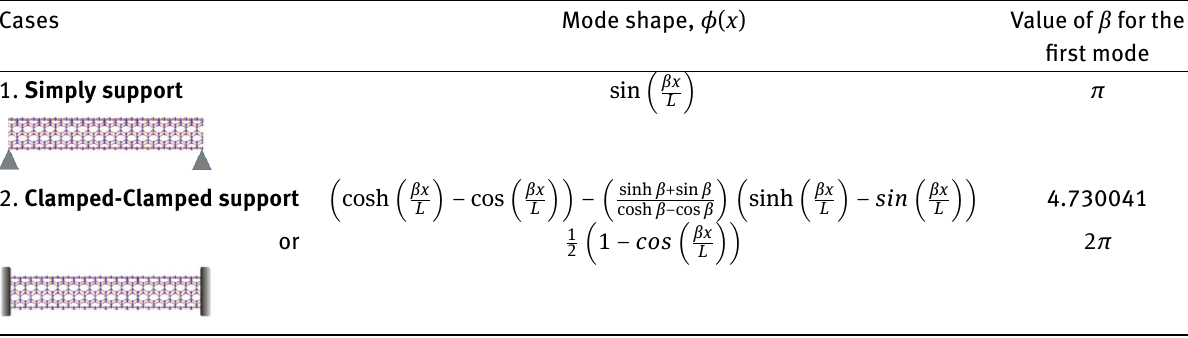
Table 1: The basic functions corresponding to the above boundary conditions